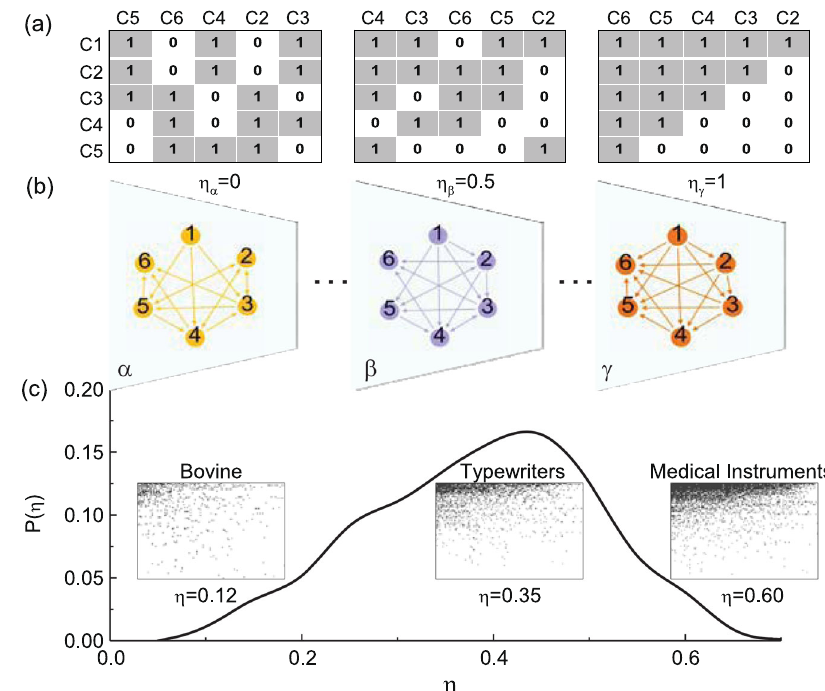
Fig. 1 Nestedness in multilayer networks. a , b Three representations of matrices, respectively, correspond to none, moderate, perfect nested network. These three networks have the same number of nodes and links. In each matrix, the rows and columns have been ranked by the number of ones (i.e., degree). In a perfectly nested matrix, the upper-left triangle would be full of elements and the lower-right triangle would have no elements. c The matrices are representations of the different layers of world trade networks which, respectively, correspond to the network of Bovine, Typewriters, and Medical Instruments. The nestedness of matrices (NODF) is 0.12, 0.37, and 0.60, respectively. The curve is the distribution of nestedness calculated by 786 matrices of